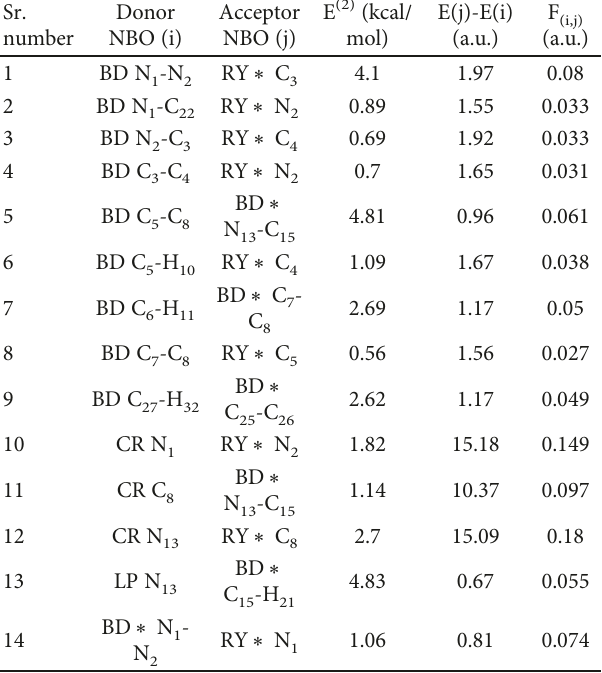
Table 4: Selected second-order perturbation theory analysis of the Fock matrix responsible for the most important donor-acceptor interactions for DMAB by a DFT/6-311G++ method in gas. Sr.